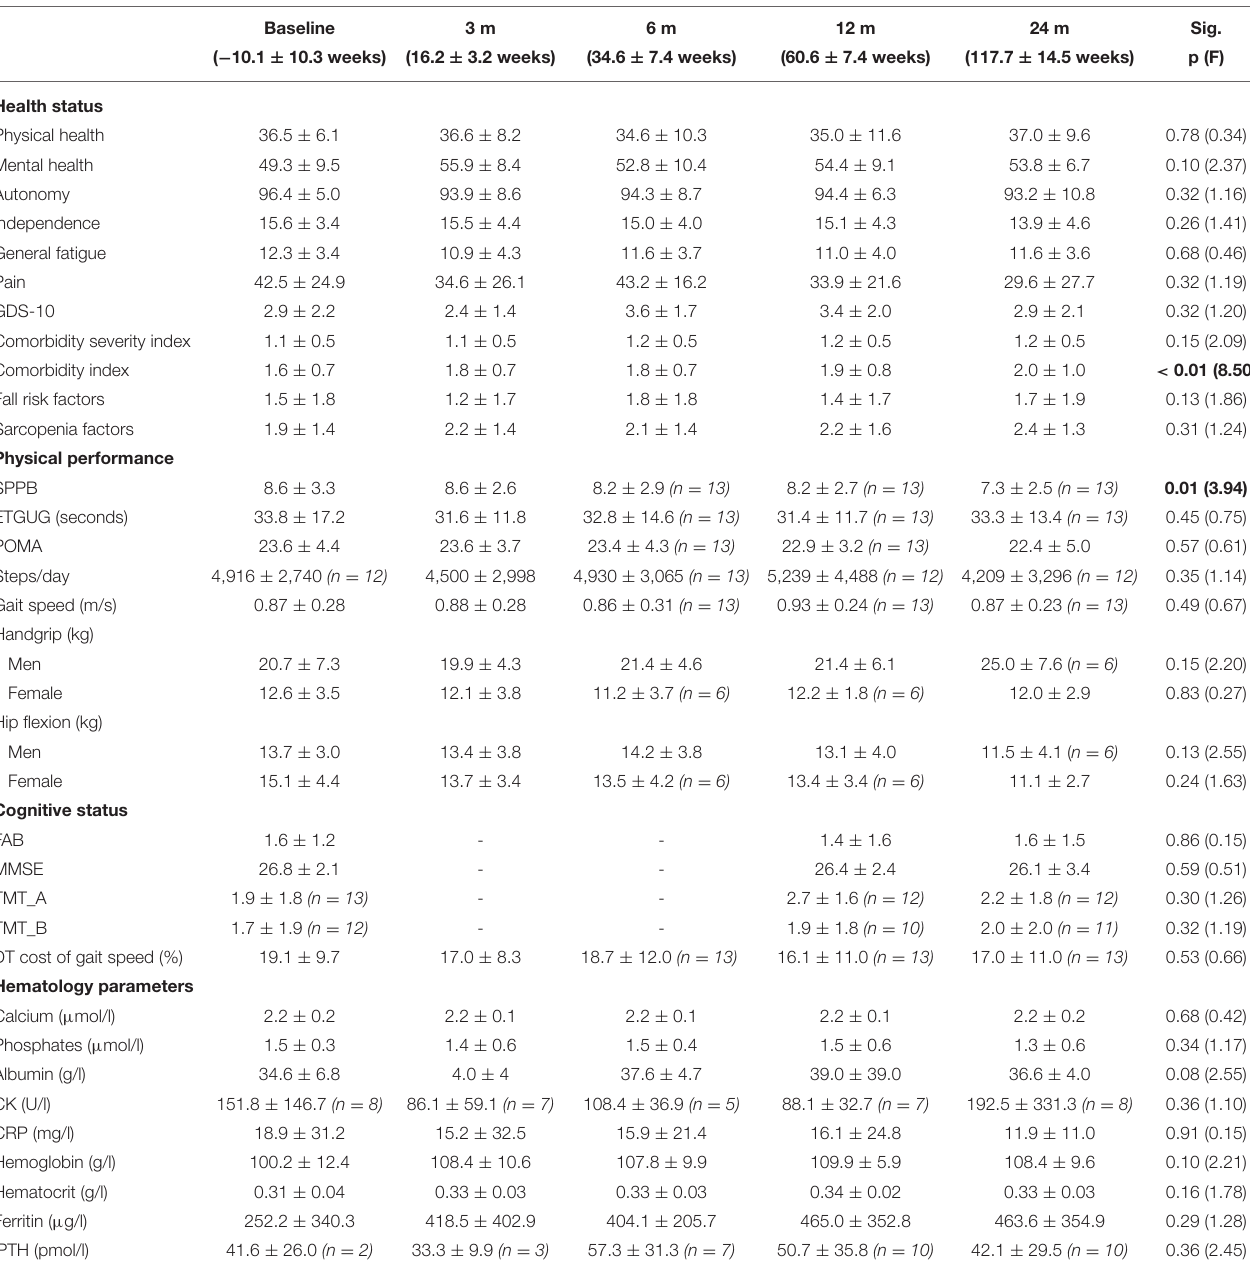
TABLE 2 | Evolution of the studied population (mean ± SD).